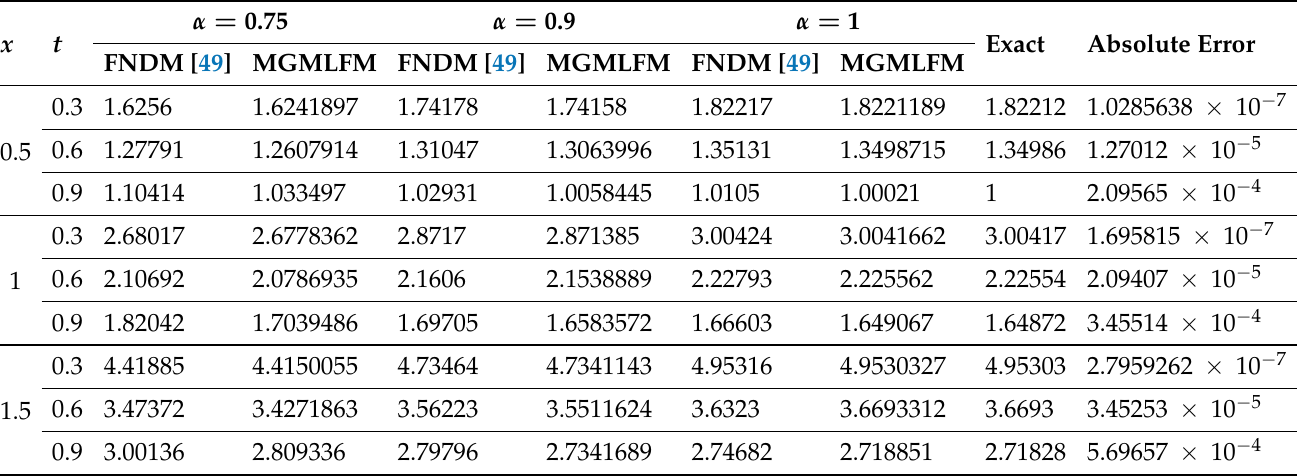
Table 4. Values of approximate solutions obtained by MGMLFM, FNDM, exact solution, and absolute errors of U for system (5) with various values of α , t , x and y = 0.4.